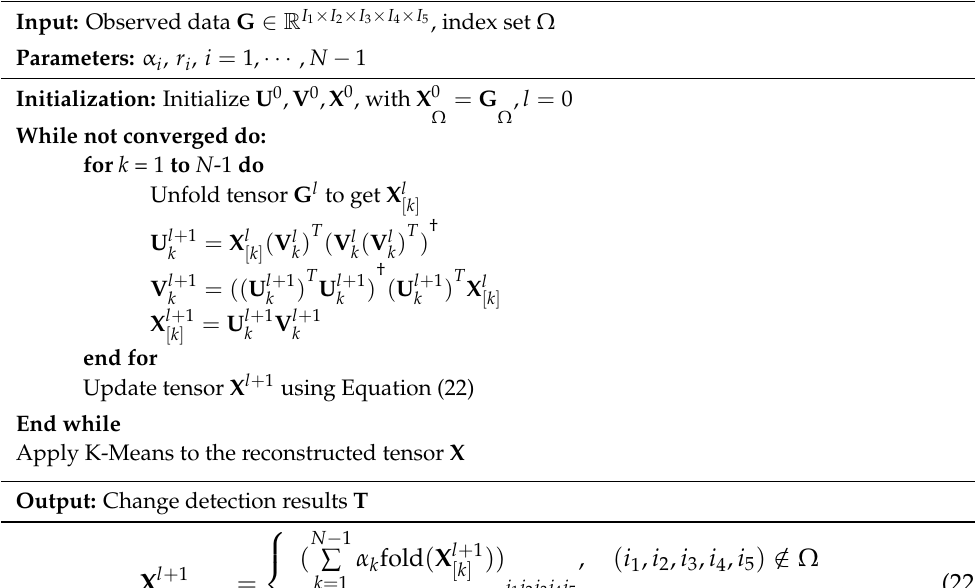
Algorithm 1. Pseudocode of the proposed UTT for multitemporal HSI change